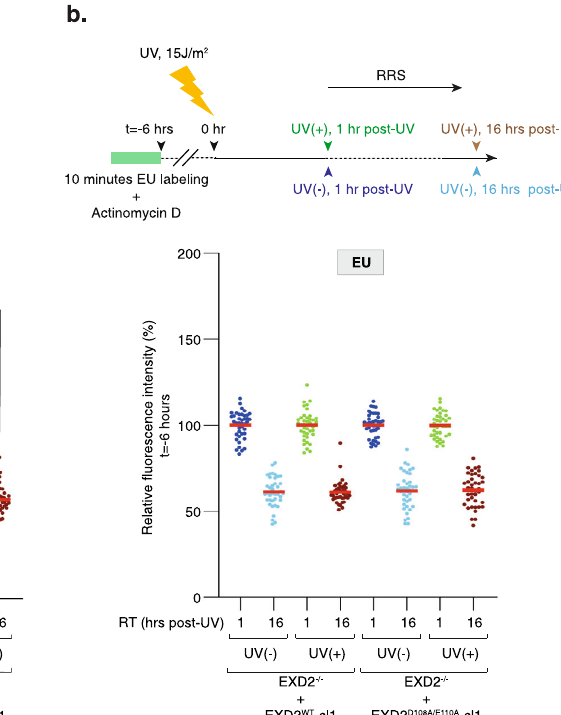
p -values.SourcedataareprovidedasaSourceData fi le. b Upperpanel;Compareto panel a , UV irradiation (15J/m 2 ) was performed 6h after EU labeling and cells were let to recover for either 1h or 16h post-UV before fi xation. Actinomycin D was maintained during the experiment. Lower panel; Cells were treated as indicated in upper panel and EU signals were quanti fi ed using ImageJ. Values are reported on the graph ( n =at least 50 cells). Red bars indicate mean integrated density. RT recoverytime.One-wayANOVAwithpost-hocTukeyadjustmentcomparisonswere used to determine the p -values. No statistically signi fi cant differences were detec- ted at 16h post-UV between EXD2 − / − +EXD2 WT -cl1 and EXD2 − / − +EXD2 D108A/E110A - cl1 cells. Source data are provided as a Source Data fi